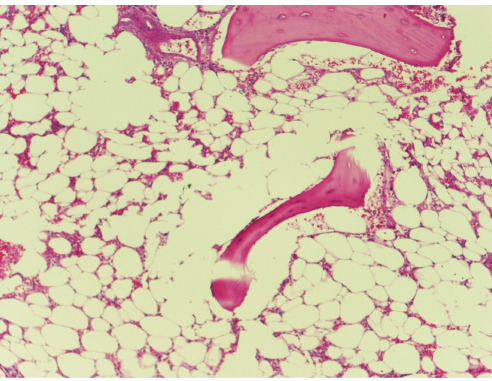
Figure 1: Severely hypocellular bone marrrow with very few erythroid and myeloid cells at any stage of di ff erentiation suggesting features of aplastic